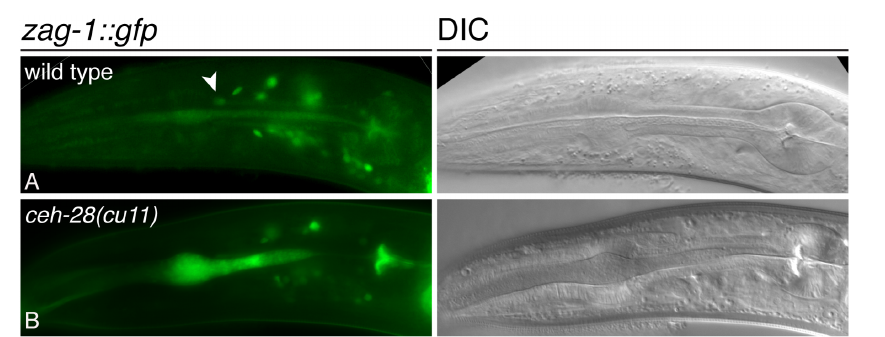
Figure 4. Expression of zag-1::gfp in wild-type and ceh-28 mutants. Fluorescence (left) and DIC (right) micrographs of zag-1::gfp wgIs83 in wild-type (A) and. ceh-28(cu11) mutant (B) adults. M4 is indicated (arrowhead) in (A). The anterior pharyngeal lumen is stuffed with bacteria in (B), and this results in non- specific autofluorescence.